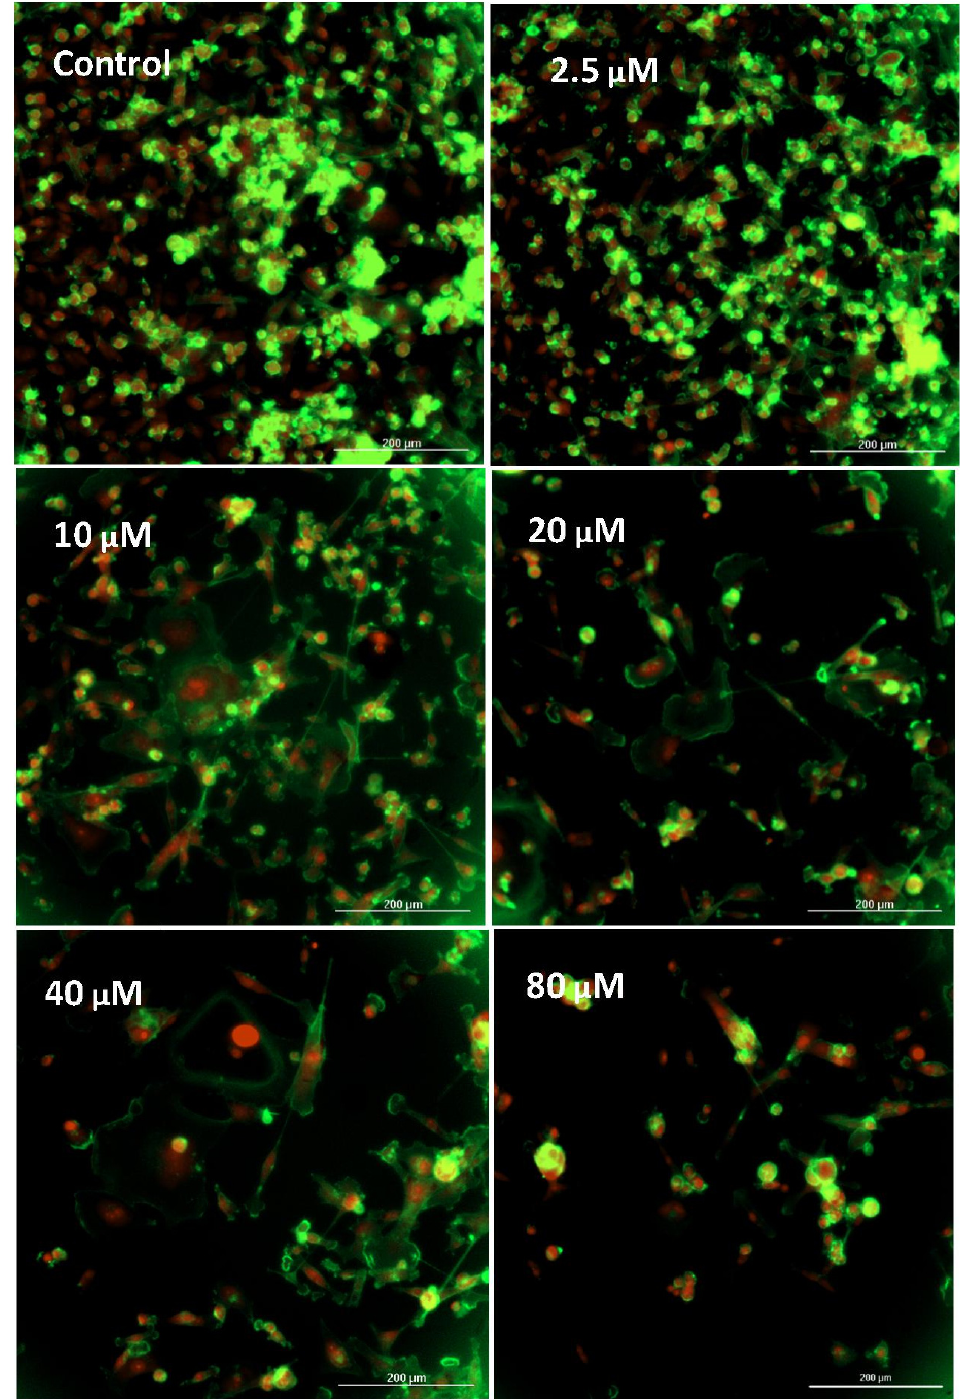
Figure 4. Cytoskeletal actin structural changes corresponding to the cytostatic effects of GNE-140 in MDA-MB-231 cells after a 7 day proliferation period. Images represent fixed, permeabilized cells which were stained with phalloidin 488 and a nuclear PI counter stain.